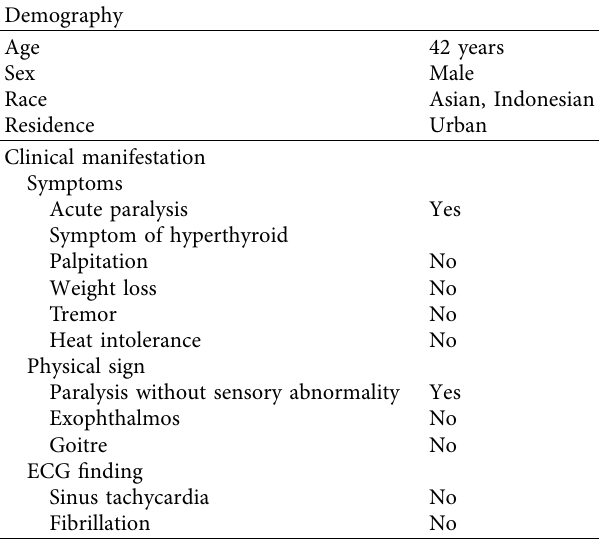
Table 1: Demographic and clinical findings of the patient.